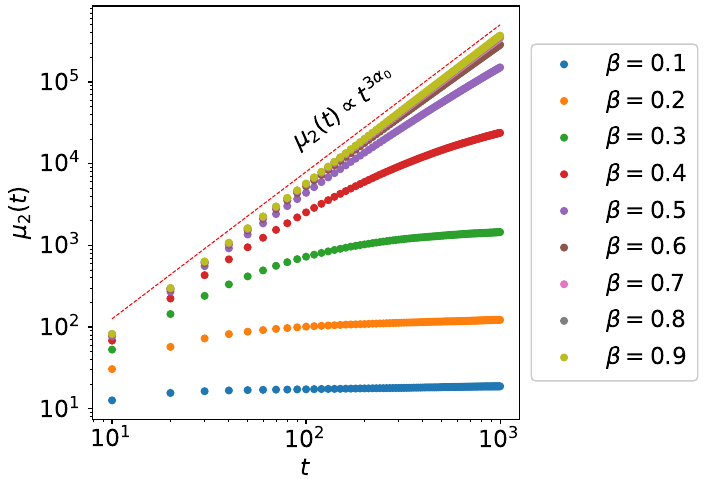
Figure 3. Plots of second moments for Monte Carlo simulated trajectories. Each value of β has N = 10 4 trajectories. The parameters used were α 0 = 0.6, ν = 1, λ = 1 and τ 0 = 10 − 4